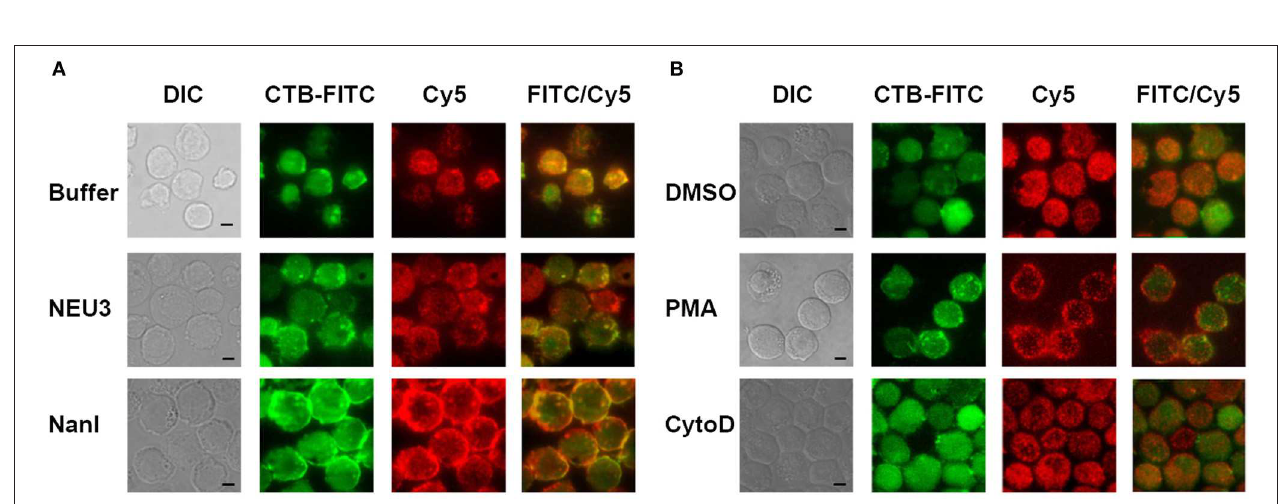
FIGURE 3 | TIRF imaging of LFA-1 on treated cells. Jurkat cells were fixed after treatment with (A) buffer (control), NEU3, or NanI ; and (B) DMSO, PMA, or cytoD. The fixed cells were then labeled with Cholera toxin subunit B (CTB-FITC) to label gangliosides and a TS2/4-Cy5 conjugate to label LFA-1. Cells were imaged by DIC and TIRF. Merged FITC and Cy5 images are shown in the last column with yellow indicating co-localization. Scale Bar = 5 µ m.